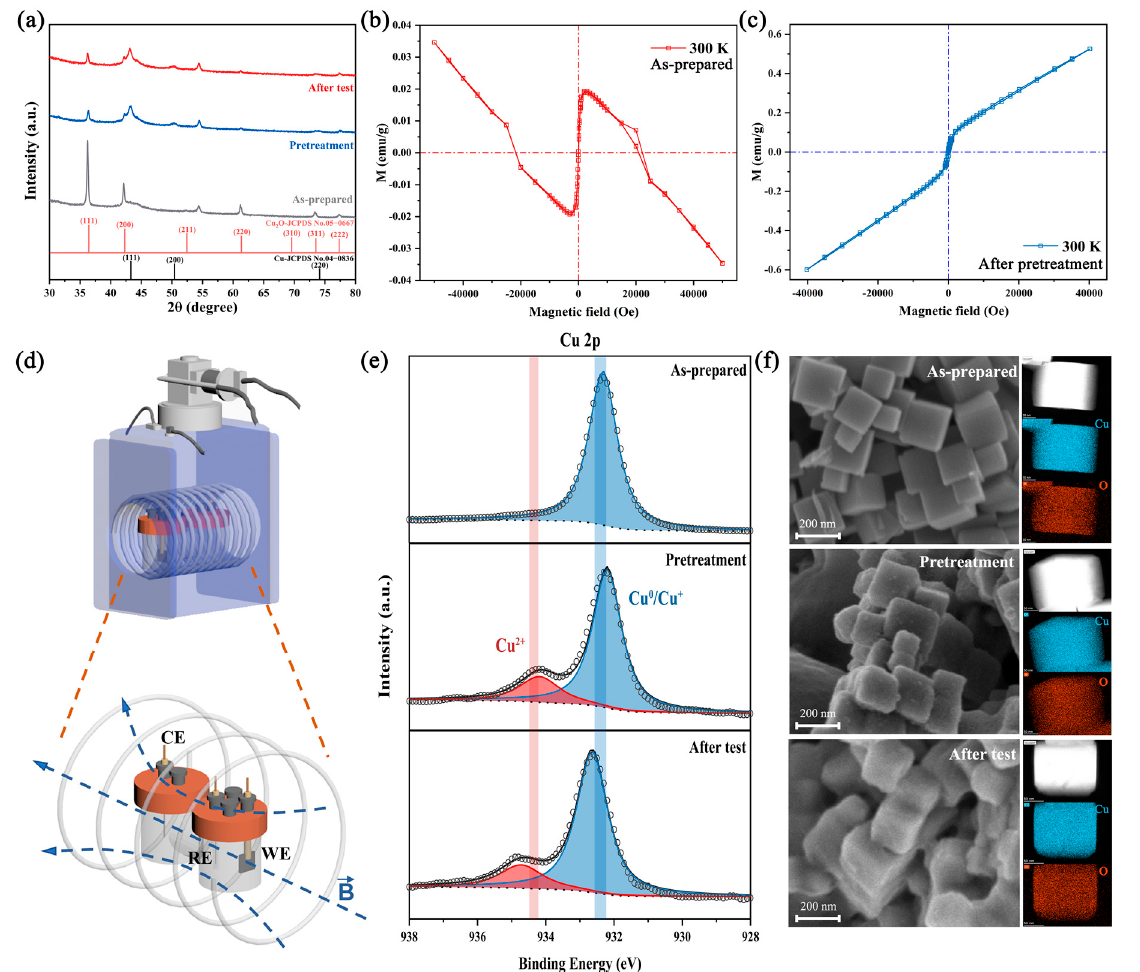
Figure 1 . Material characterization of the catalyst: ( a ) XRD pattern of the as-prepared, pretreated and after-test catalyst. ( b , c ) The M(H) curves at 300 K of the as-prepared and pretreated catalyst. ( d ) The schematic diagram of the magnetic field device and electrochemical H-cell. ( e ) XPS spectra of Cu 2p of the as-prepared, pretreated and after-test catalyst. ( f ) SEM images and EDS mapping of the as-prepared, pretreated and after-test Cu 2 O nanocubes.